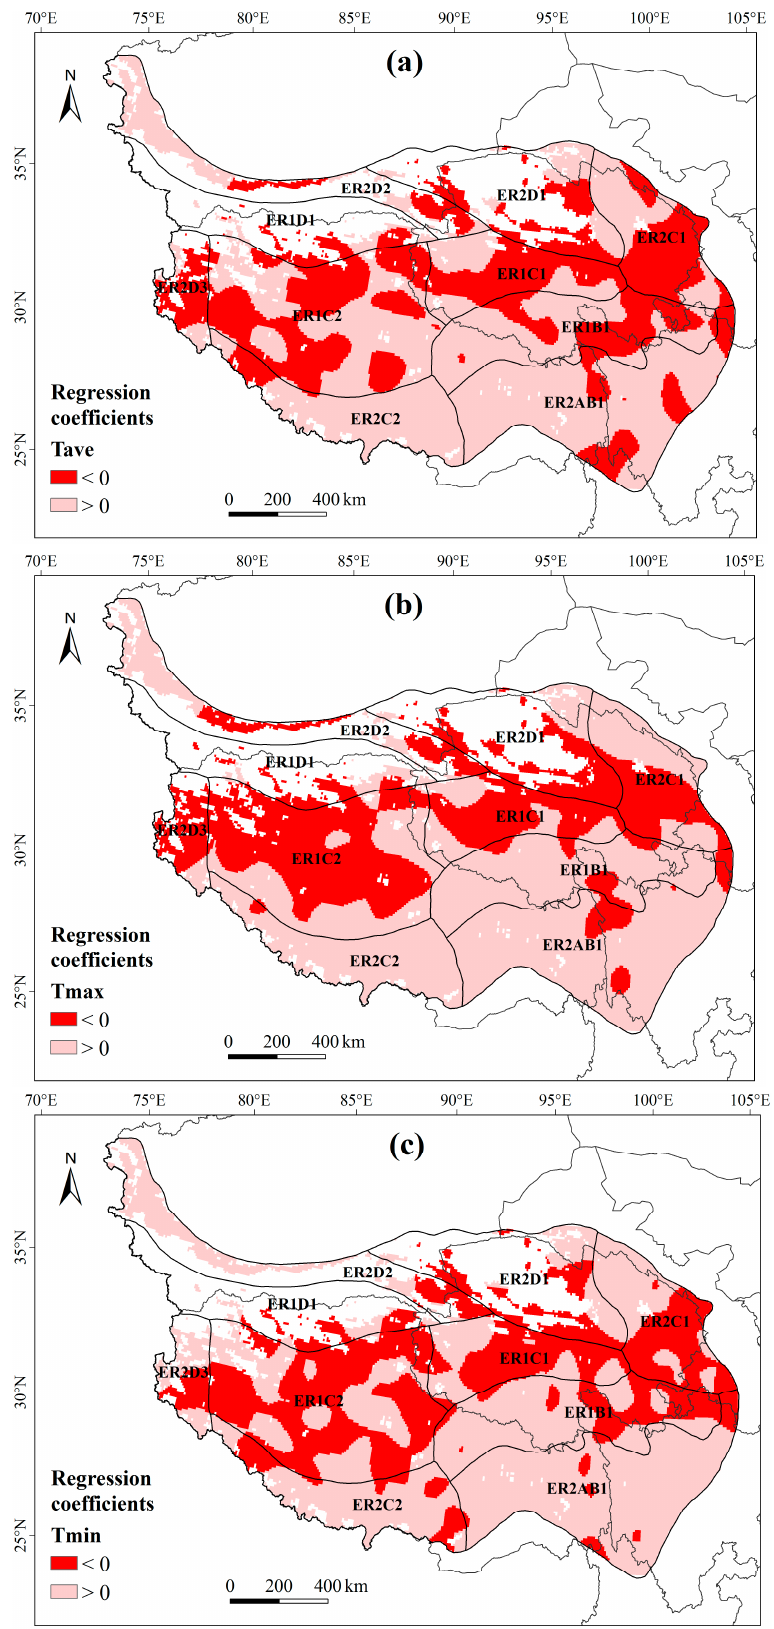
Figure 6. The spatial regression coefficients between NDVI variability and temperature